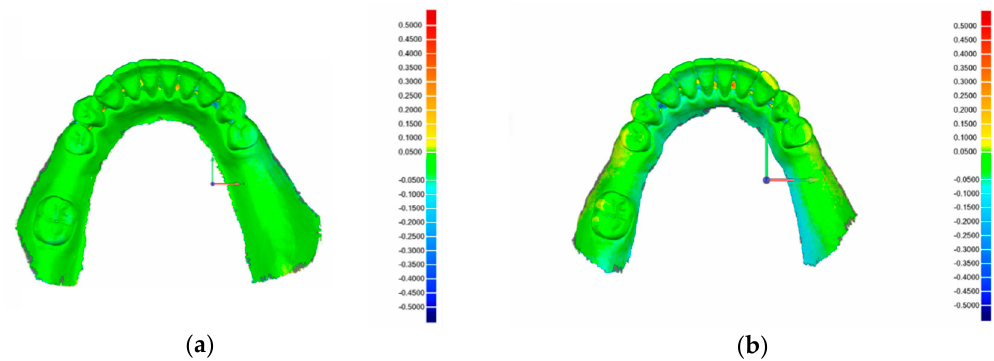
Figure 2. Comparison of the 3D surface scans of each model. ( a ) Aside from the interdental spaces with undercuts, only the models with a surface discrepancy of less than 0.05 mm (green area) were selected. ( b ) Models with surface discrepancies larger than 0.05 mm (yellow or blue area) were excluded.